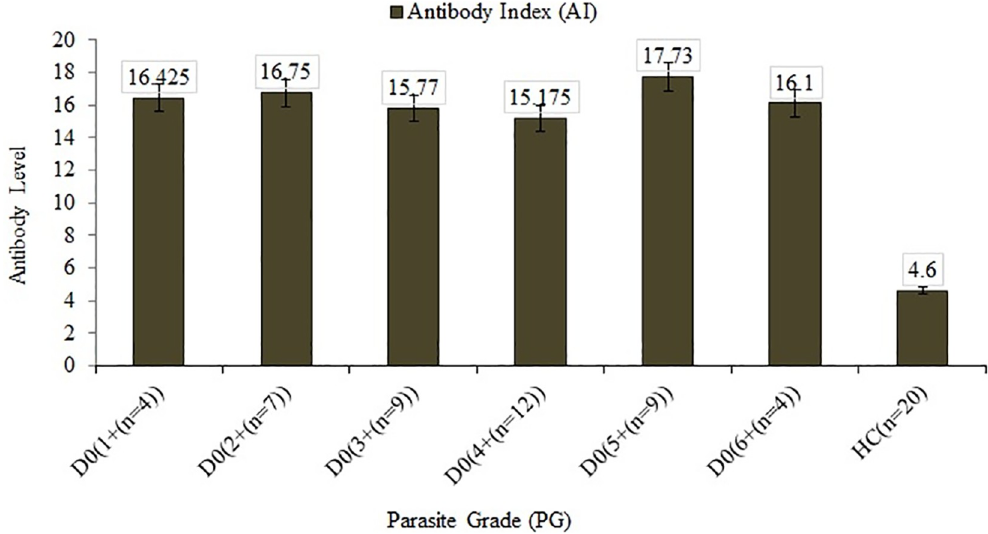
Fig 6. Comparison of parasite grade and anti-leishmanial antibody levels measured with Indirect